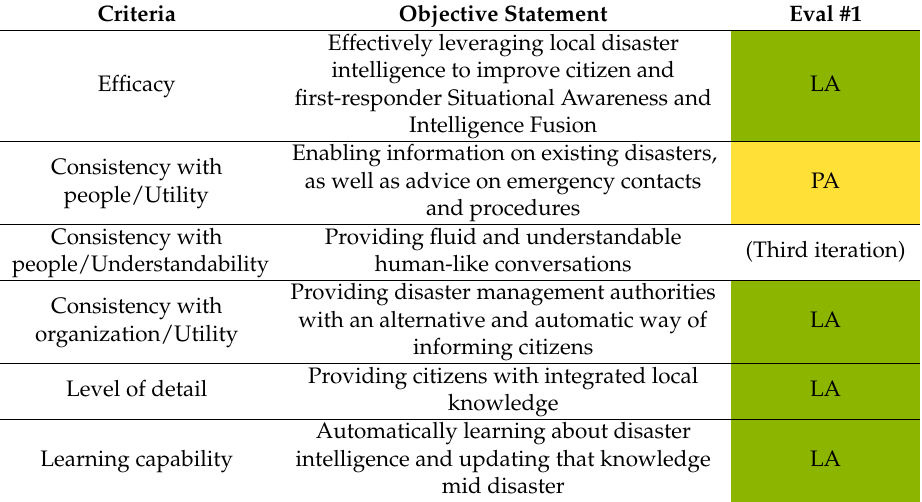
Table 7. Results of the first DSRM